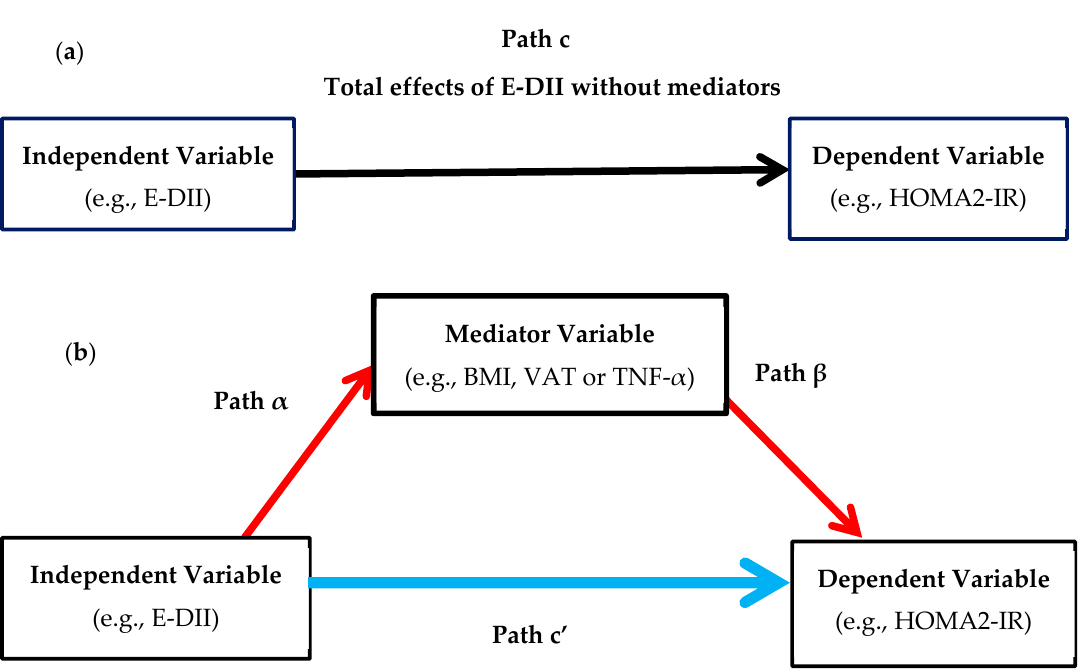
(Figure 2b). Path c’ represents the direct e ff ect of E-DII on markers of T2D after controlling for the e ff ect of the mediator